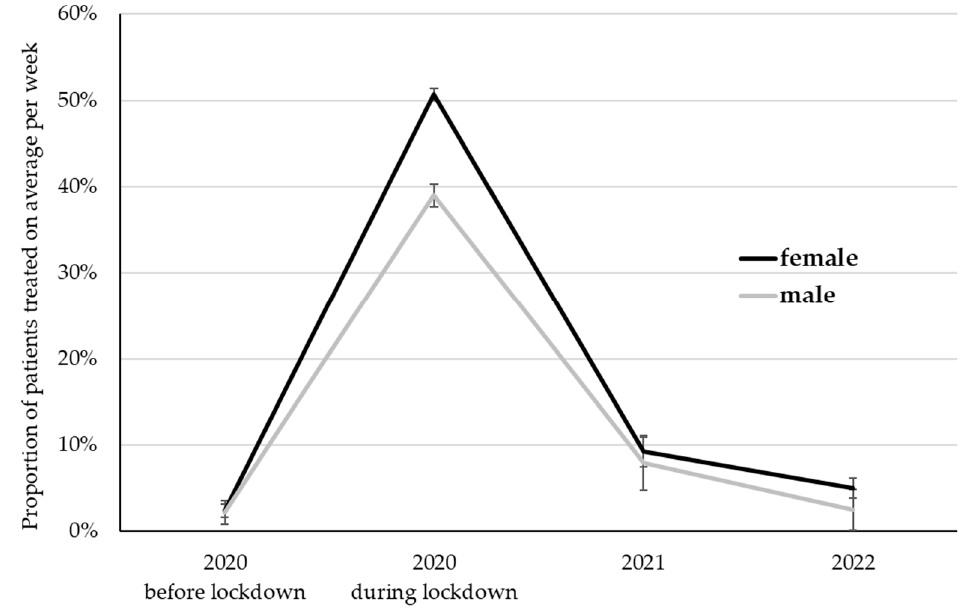
Figure 4. The proportion of patients treated on average per week via the telephone. LS Mean ± standard error.